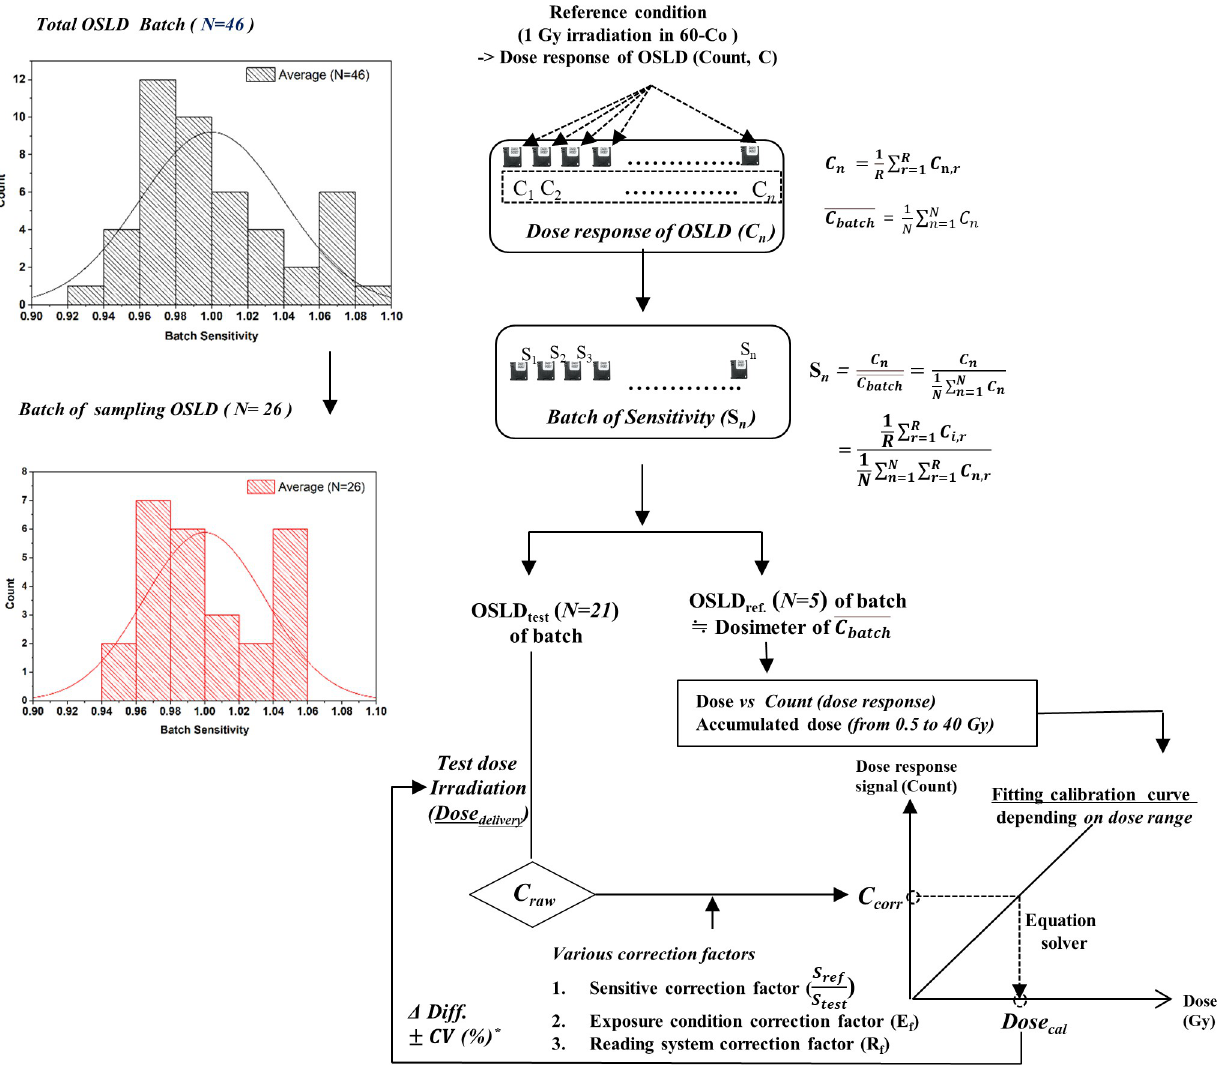
Fig 2. Overall concept for dose evaluation with OSLD depending on dose range. https://doi.org/10.1371/journal.pone.0266110.g002 according to the dose range for the relationship between the dose and the dose response (count). Second, it was designed to correct the measured count acquired from the test dosime- ters irradiated with a dose. The sensitivity correction factor, exposure condition correction fac- tor (the energy, angular correction factor), and the reading system correction factor (the fading and depletion correction factors) were used to correct the sensitivity of the dosimeters used for testing and determining the dose-response curve. Third, it was designed to inversely calculate the dose by applying the count value corrected by the various correction factors to the fitting function of the dose-response curve determined by the dose range. The fitting func- tion was selected based on the target dose and the target. Furthermore, the target and calcu- lated doses were compared, and the percentage difference was calculated using Eq (5): (cid:0) D D target eval : ; % ð Þ ¼ � 100 ; ð 5 Þ Dose Diff : D dose D target